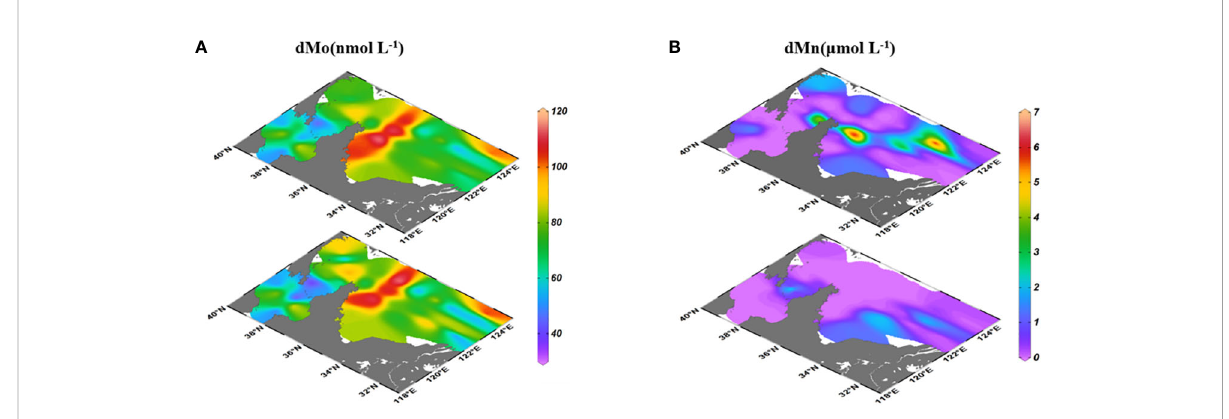
FIGURE 2 Distributions of dMo (A) and dMn (B) in surface and bottom seawaters of the BS and